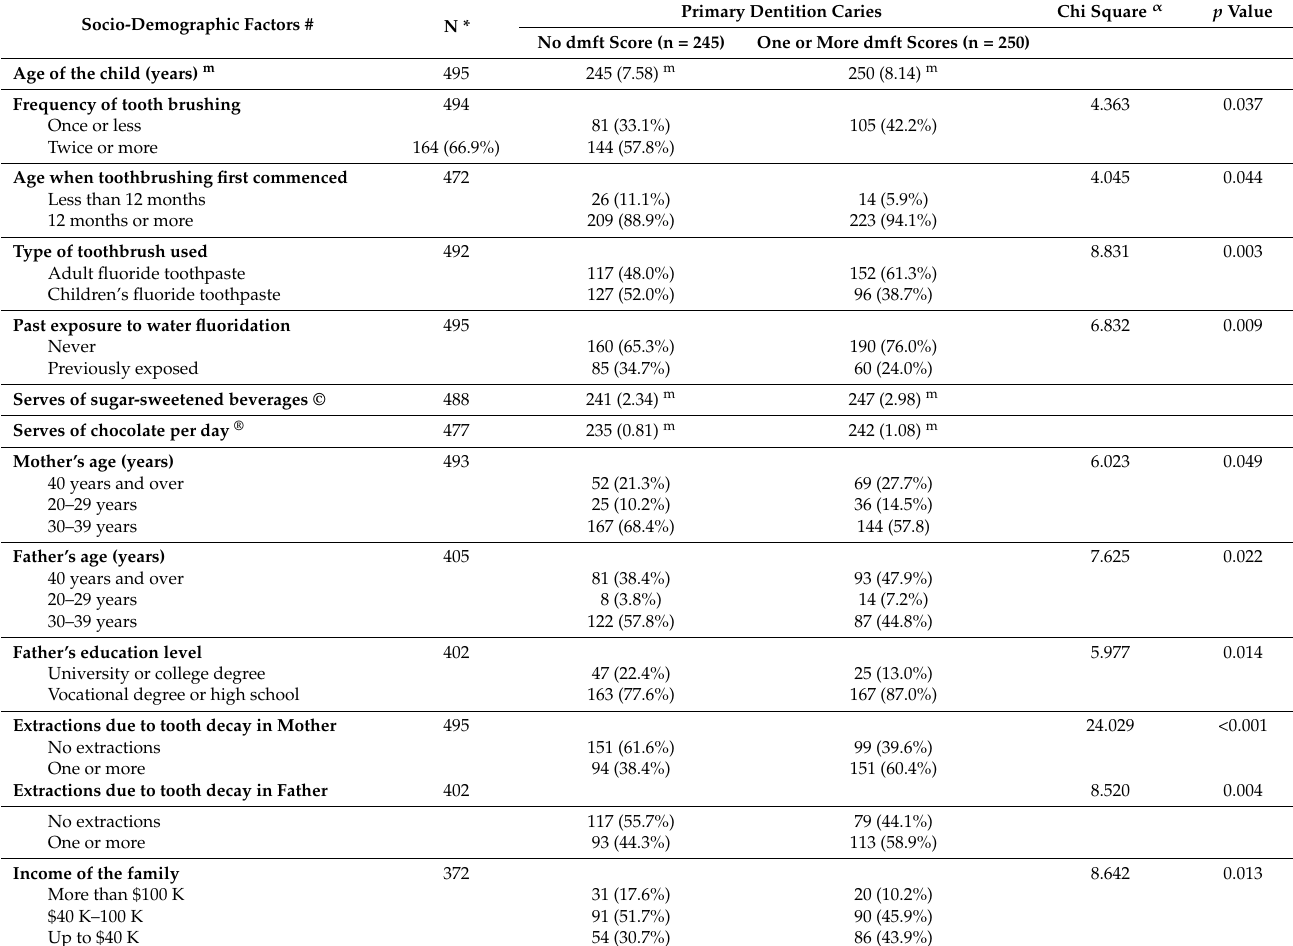
Table 1. Socio-behavioural factors influencing caries in primary dentition among primary school children of Lithgow Local Government Area (LGA) (n = 495). Socio-Demographic Factors